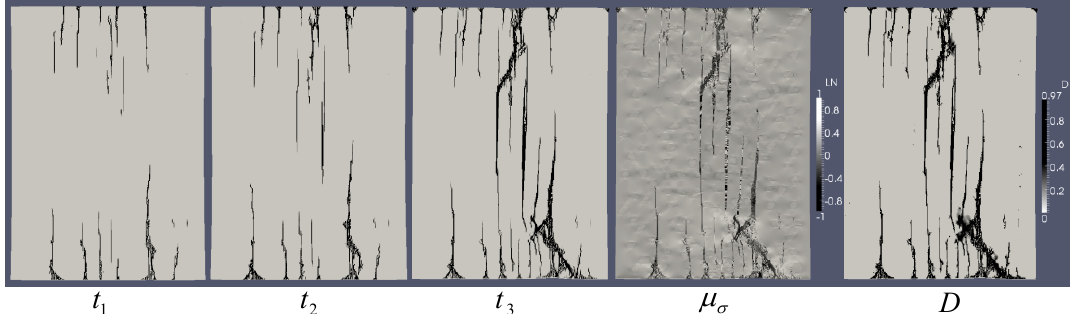
 ), damage function ( D ) in the 